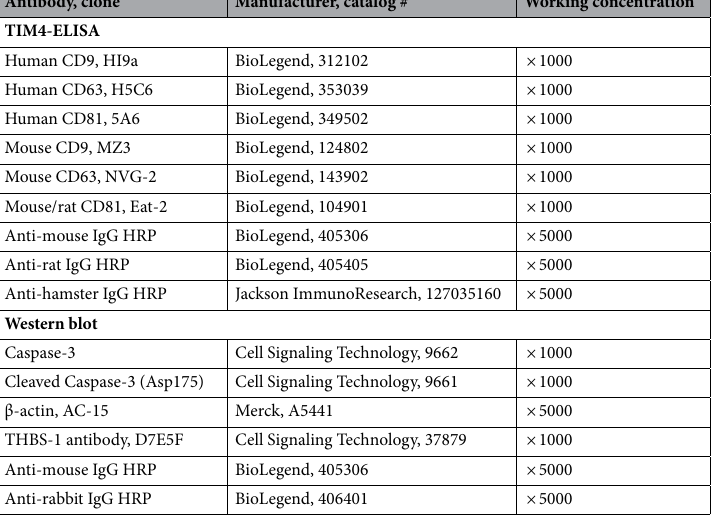
Table 4. Antibodies used in TIM4-ELISA or western